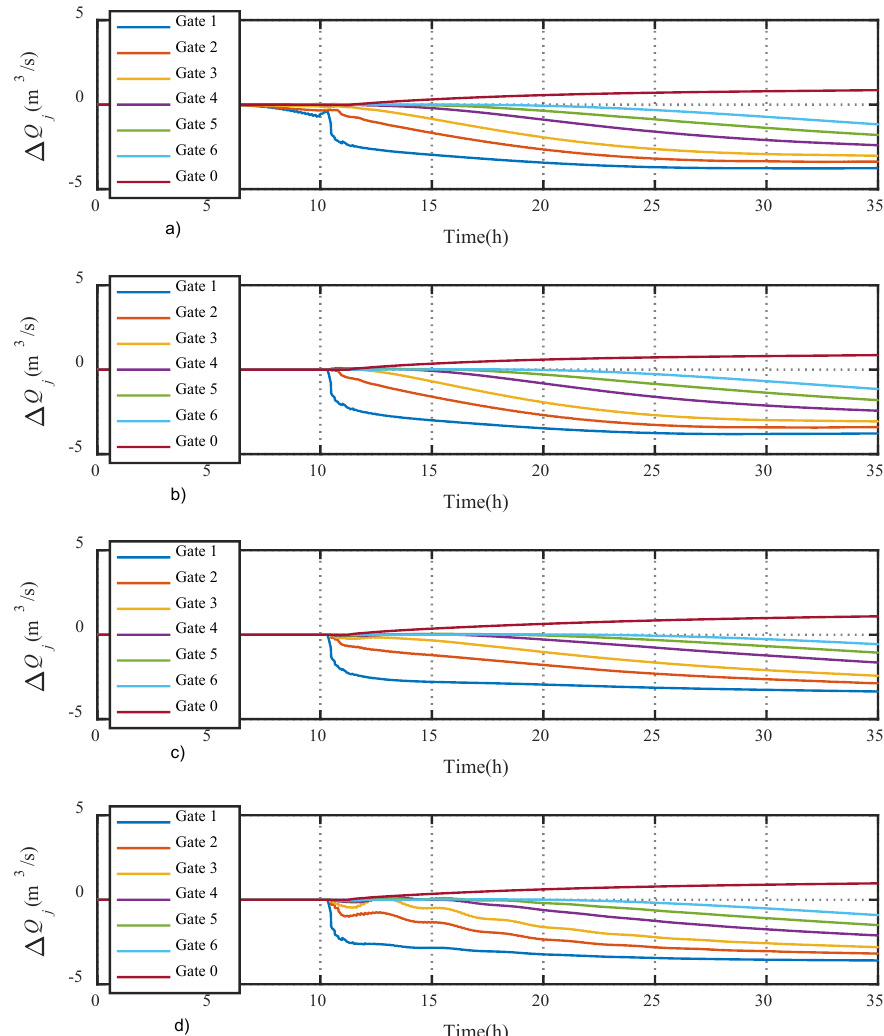
Figure 7. The simulation flow change result for scenario No. 3 with MPC-I control ( a ), MPC-I control ( b ), LQR I ( c ), and LQR II ( d ).